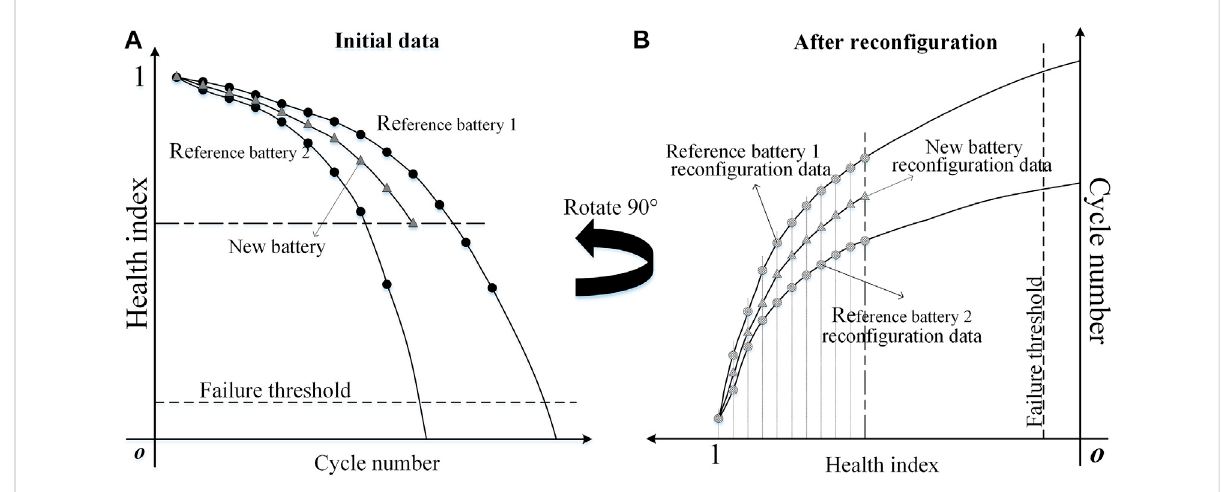
FIGURE 2 The coordinate recon fi guration of the performance degradation trajectory of lithium-ion